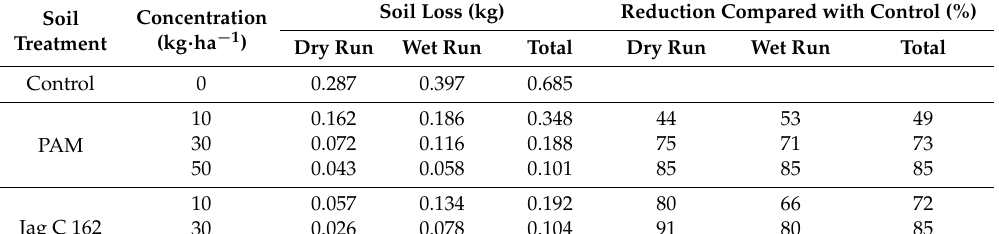
Table 2. Soil losses from soil surface treated with different concentrations of PAM and Jag C 162. Concentration (kg·ha − 1 ) Soil Treatment